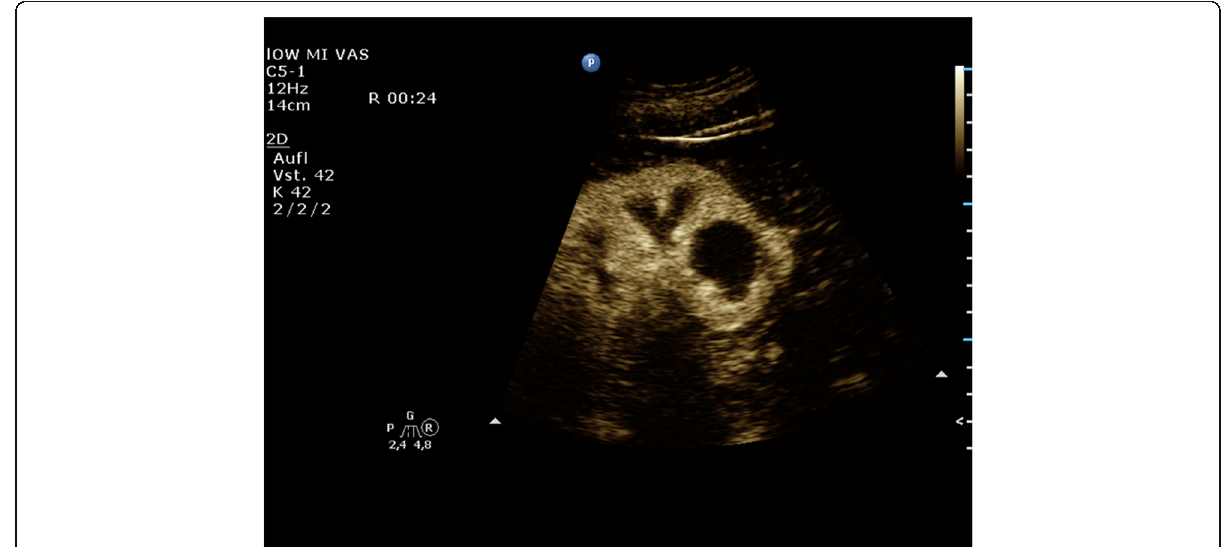
Fig. 2 Philips Healthcare CX50: No contrast enhancement of the cyst can be detected; thus, the cyst can be classified as Bosniak type